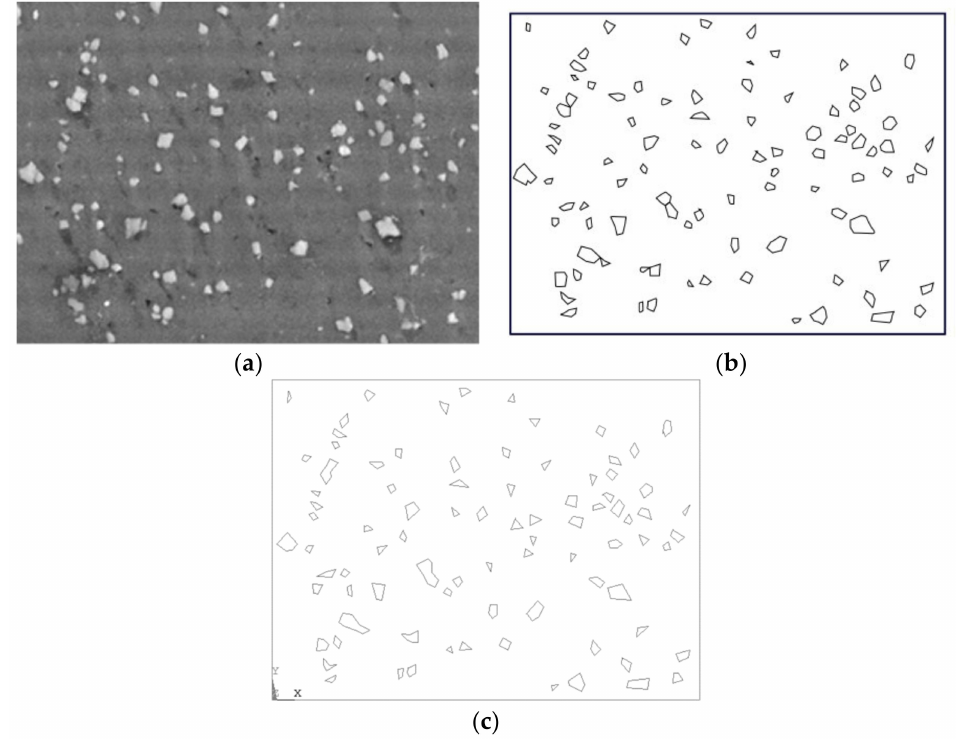
Figure 3. Microstructural modeling. ( a ) Real composite microstructure; ( b ) Segmented microstructure; ( c ) Computational domain of the composite